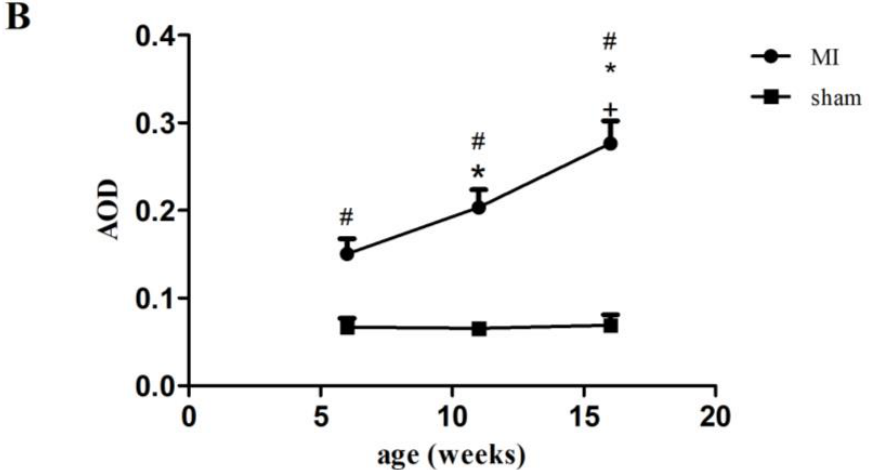
Figure 1. Type I collagen expression in left ventricular non-infarcted region of rats. MI, myocardial infarction; sham, rats having undergone a sham operation; 16w sham, 16-week post-sham-operation group; 6w MI, 6-week post-infarction group; 11w MI, 11-week post-infarction group; 16w-MI, 16- week post-infarction group. ( A ) Representative images of immunohistochemical staining for type I collagen (collagen I) (magnification: × 200). Blue indicates nucleus, and brown indicates collagen I. ( B ) Graphical representation of collagens I protein expression in the sections. AOD, average optical density; the results are presented as mean ± SD. # p < 0.05 vs. sham-operated rats of the same age; * p < 0.05 vs. 6w MI; + p < 0.05 vs. 11w MI.